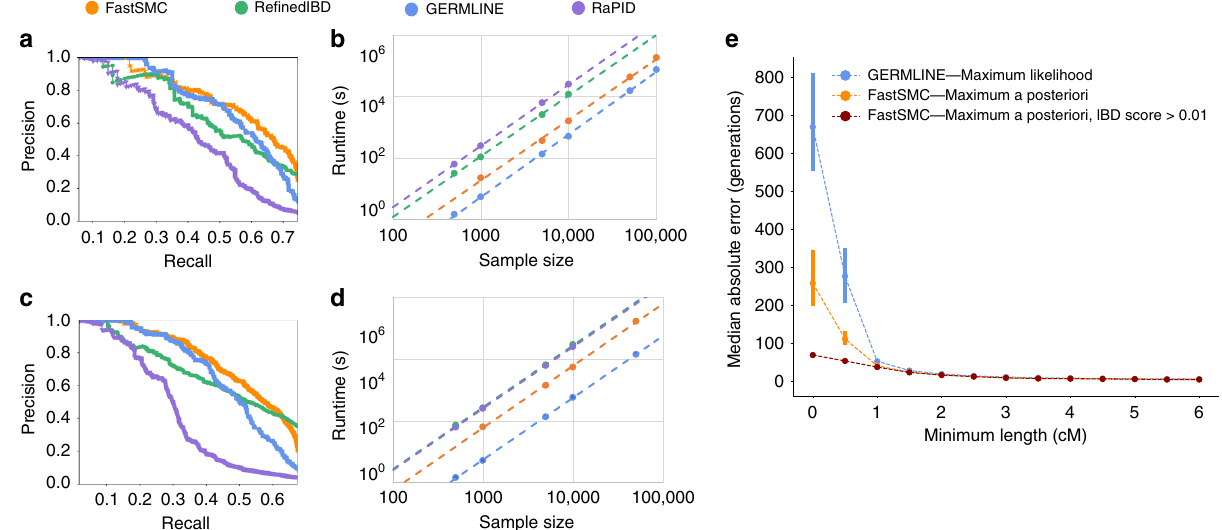
Fig. 1 FastSMC in coalescent simulations. a (respectively c ). Precision-recall curve randomly sampled from 10 realistic European simulated datasets with 300 haploid samples for IBD segments detection within the past 50 generations (respectively 100 generations), within the recall range where all methods are able to provide predictions. b (respectively d ). Running time (CPU seconds) using chromosome 20 of the UK Biobank for IBD segments detection within the past 50 generations (respectively 100 generations). The entire cohort of 487, 409 samples (across 7913 SNPs) was randomly downsampled into smaller batches. Only one thread was used for each method and running time trend lines in logarithmic scale are shown, re fl ecting differences in the quadratic components of each algorithm. Parameters for all methods were optimized to maximize accuracy and used for both accuracy and running time benchmarking (details in Methods section). e Median absolute error of the length-based maximum likelihood age estimate (MLE) on segments detected by GERMLINE in blue and our MAP age estimate on segments detected by FastSMC (no fi ltering on the IBD quality score in orange, and a minimum IBD quality score of 0.01 in dark red) for 300 haploid simulated samples with European ancestry. As a reference, the average TMRCA at a random site for a pair is in the order of several thousands of generations 23 . Only detected IBD segments longer than the minimum length represented on the X -axis were considered. We ran both algorithms with the same minimum length of 0.001 cM and other parameters from grid search results for a time threshold of 50 generations. Data are represented as mean values ± SEM over 10